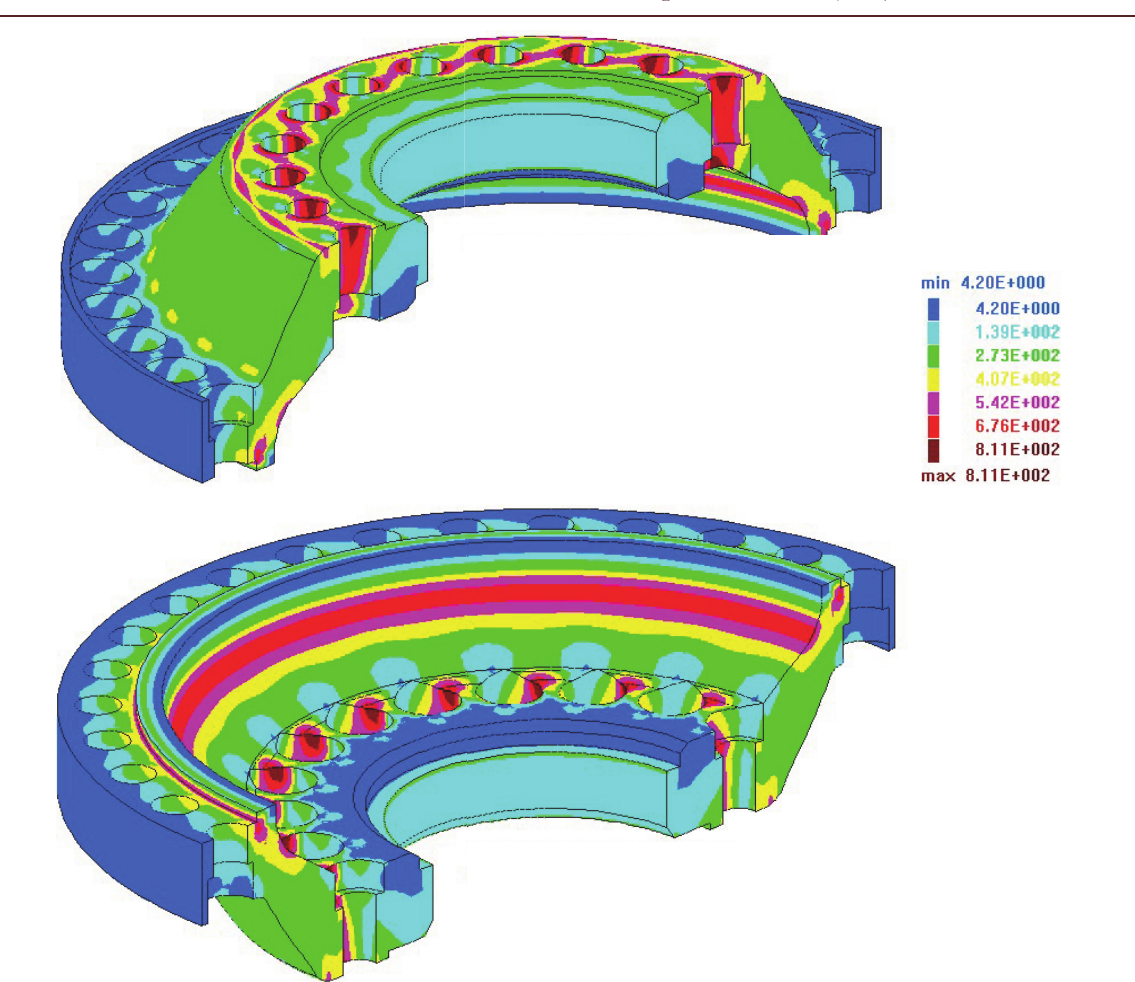
Figure 3: Equivalent stresses for combined loading (pressure, axial force,